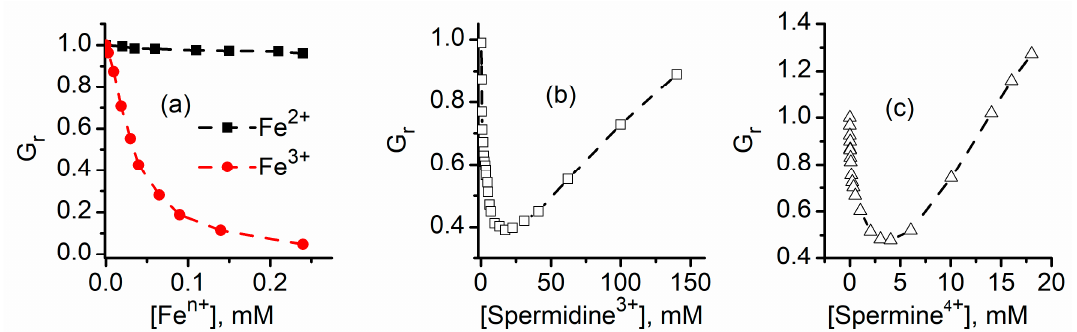
Figure 8. Charge and size influence on the inhibitory effects of multivalent cations. ( a ) The inhibitory effects presented by Fe strongly depend on the ionic charge, and Fe 3+ is a more efficient inhibitor than Fe 2+ . Voluminous organic ions, such as spermidine 3+ ( b ) or spermine 4+ ( c ), present less inhibitory efficiency, in spite of their large charge. Additionally, the inflection point in the inhibition curves indicates that both cations modulate the channel’s conductance by inducing transitions to sub-conducting states. Adapted from [62] (panels a , b ) and [61] (panel c ), with permission.